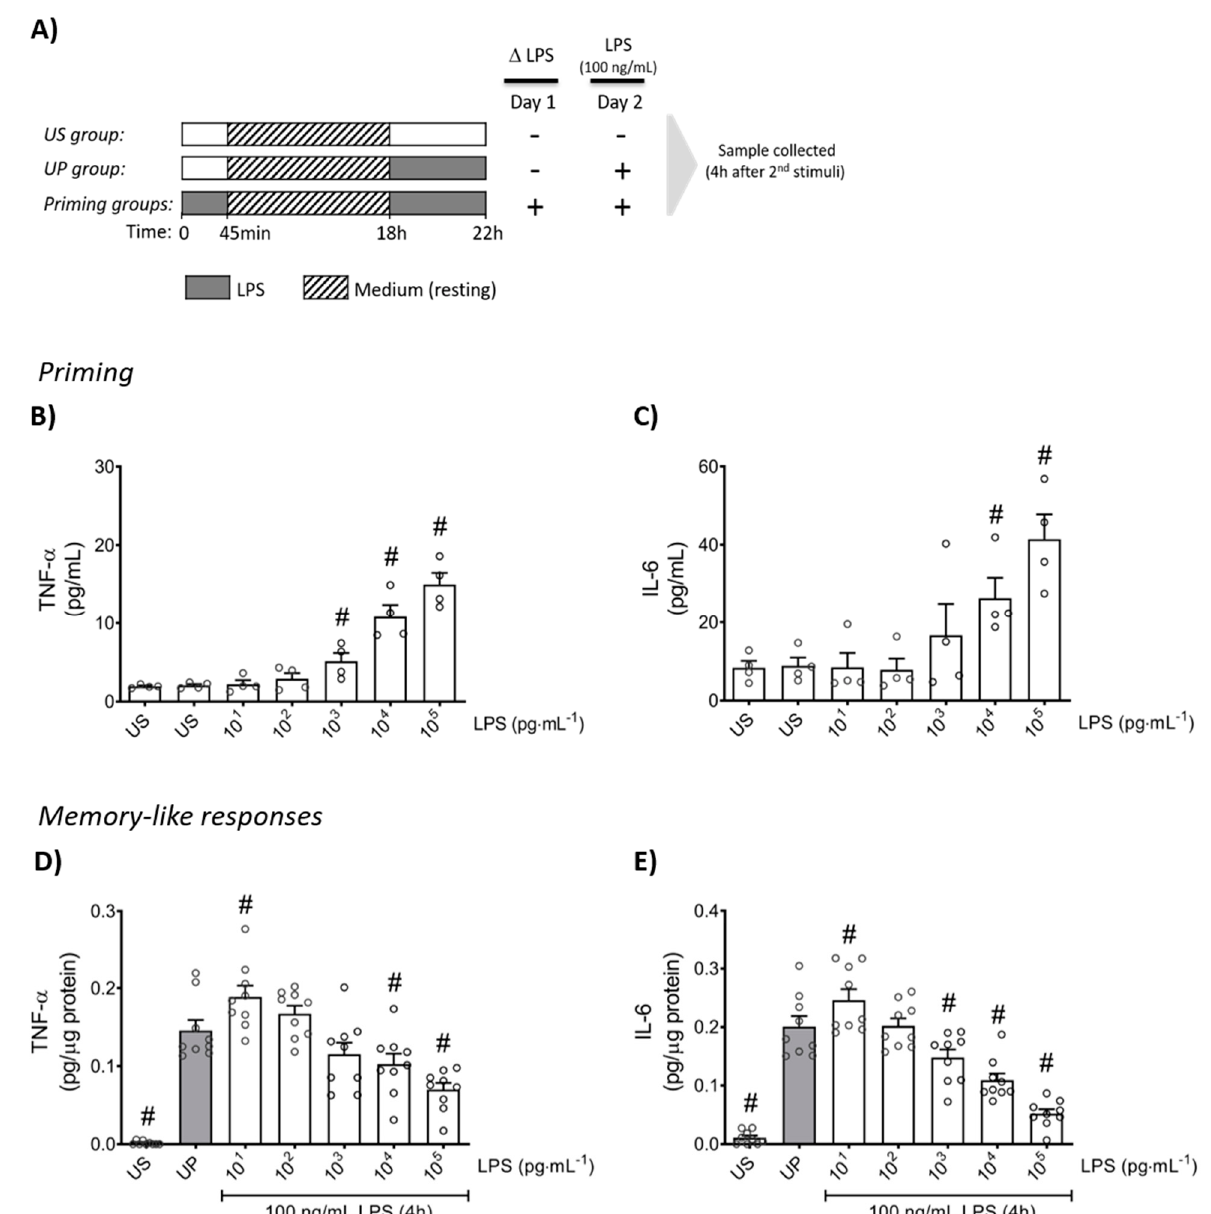
Figure 1. Cytokine responses of mouse bone marrow neutrophils primed by increasing doses of LPS. ( A ) Two-step stimulating schema used to induce memory-like inflammatory responses. Bone marrow neutrophils (1,000,000 cells/well) isolated from adult mice were stimulated with different doses of LPS (10 pg/mL to 100 ng/mL) on day 1 immediately after isolation for 45 min. Then, cells were washed and left in medium to rest for 18 h. On the next day (day 2), cells were re-stimulated with a fixed dose of LPS (100 ng/mL) for 4 h, followed by sample collection after the incubation time and processed for further analysis. Cytokine production of ( B ) TNF- α (n = 4) and ( C ) IL-6 (n = 4) by mouse bone marrow neutrophils stimulated (primed) with increasing doses of LPS analyzed by ELISA. ( D , E ) Opposing inflammatory responses of mouse bone marrow neutrophils primed by increasing doses of LPS, after a second challenge by a fixed dose LPS (100 ng/mL). Cytokine levels ( D : TNF- α , n = 9; E : IL-6, n = 9) assessed by ELISA (normalized to total protein concentration). Data are shown as scatter dot plots, mean + SEM, # p < 0.05, #significant differences vs. unstimulated condition (US) ( B , C ); # p < 0.05, #significant differences vs. unprimed condition (UP, gray column) ( D , E ).